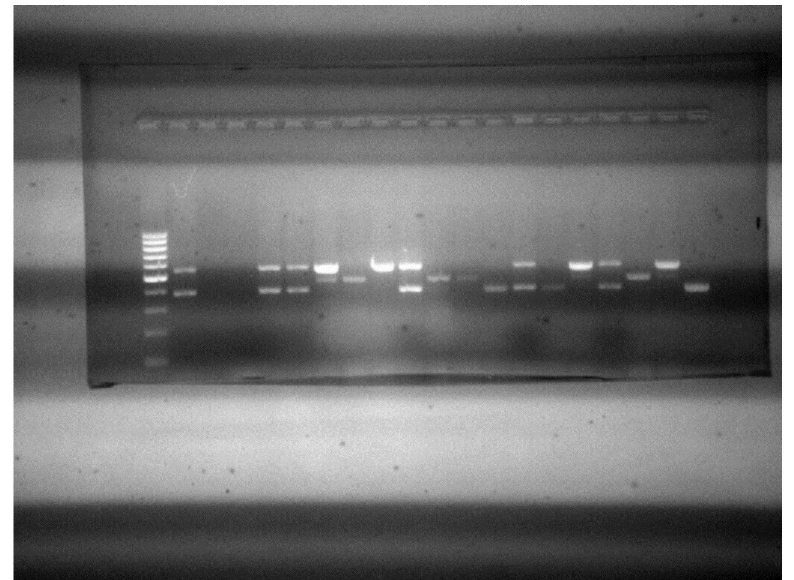
Fig 1. Gel electrophoresis detection of ESBL-producing genes among E . coli and K . pneumoniae isolates. Results by lane: 1- ladder (100bp); 2- K . pneumoniae (ATCC 700603) CTX-M-15 + SHV-38 genes; 3- E . coli (ATCC 25922); 4-Undetected; 5,6,10,14,17- CTX-M-15 + SHV-38 genes; 13,15,20- SHV-38 gene; 7,16,19- CTX-M-15 + TEM-1 genes; 8,11,12,18- TEM-1 gene.